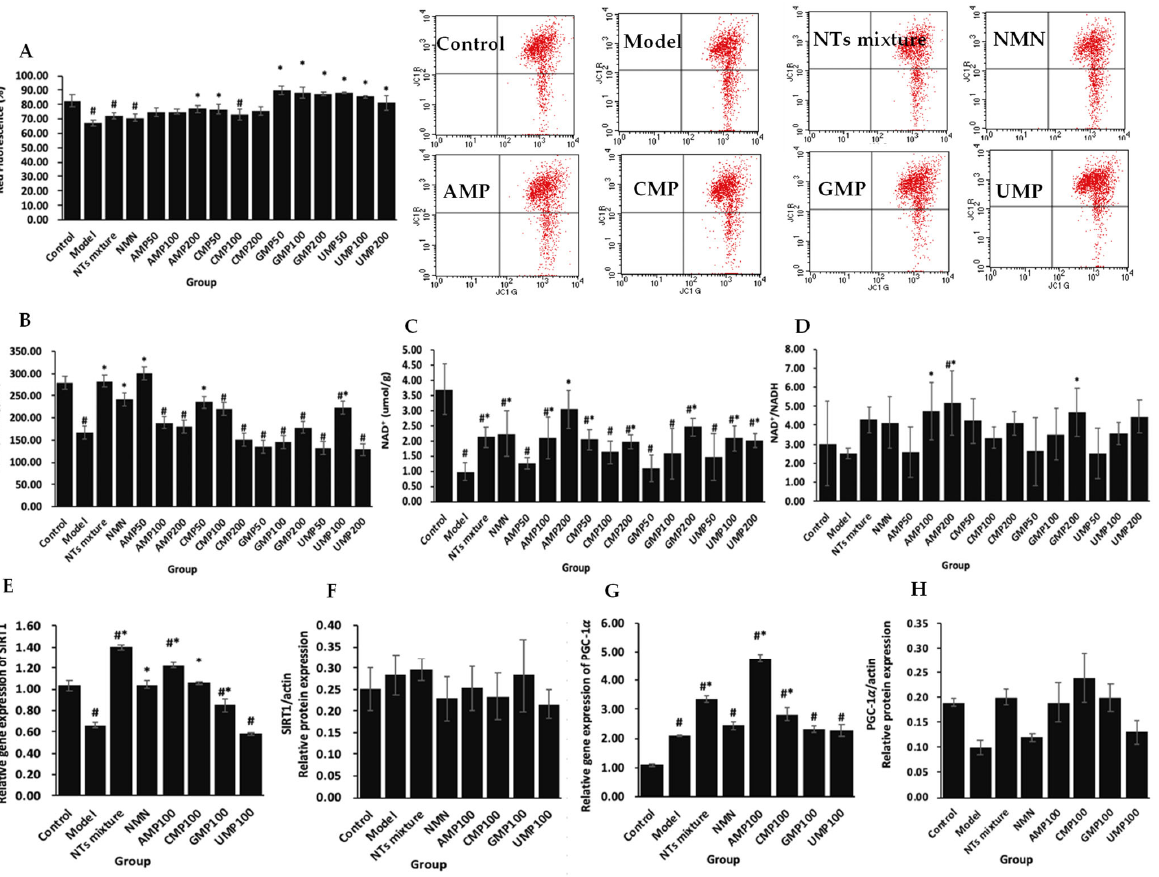
Figure 3. ( A ) The effect of NTs on the mitochondrial membrane potential in H 2 O 2 ‐ treated PC ‐ 12 cells; ( B ) The effect of NTs on the ATP production in H 2 O 2 ‐ treated PC ‐ 12 cells; ( C ) The effect of NTs on the NAD + levels in H 2 O 2 ‐ treated PC ‐ 12 cells; ( D ) The effect of NTs on NAD + /NADH in H 2 O 2 ‐ treated PC ‐ 12 cells; ( E ) The effect of NTs on the relative gene expression of SIRT1 in H 2 O 2 ‐ treated PC ‐ 12 cells; ( F ) The effect of NTs on the relative protein expression of SIRT1 in H 2 O 2 ‐ treated PC ‐ 12 cells; ( G ) The effect of NTs on the relative gene expression of PGC ‐ 1 α in H 2 O 2 ‐ treated PC ‐ 12 cells; ( H ) The effect of NTs on the relative protein expression of PGC ‐ 1 α in H 2 O 2 ‐ treated PC ‐ 12 cells. Values represented the mean ± S.D. ( n = 3 per group). # p < 0.05 versus control group, * p < 0.05 versus model